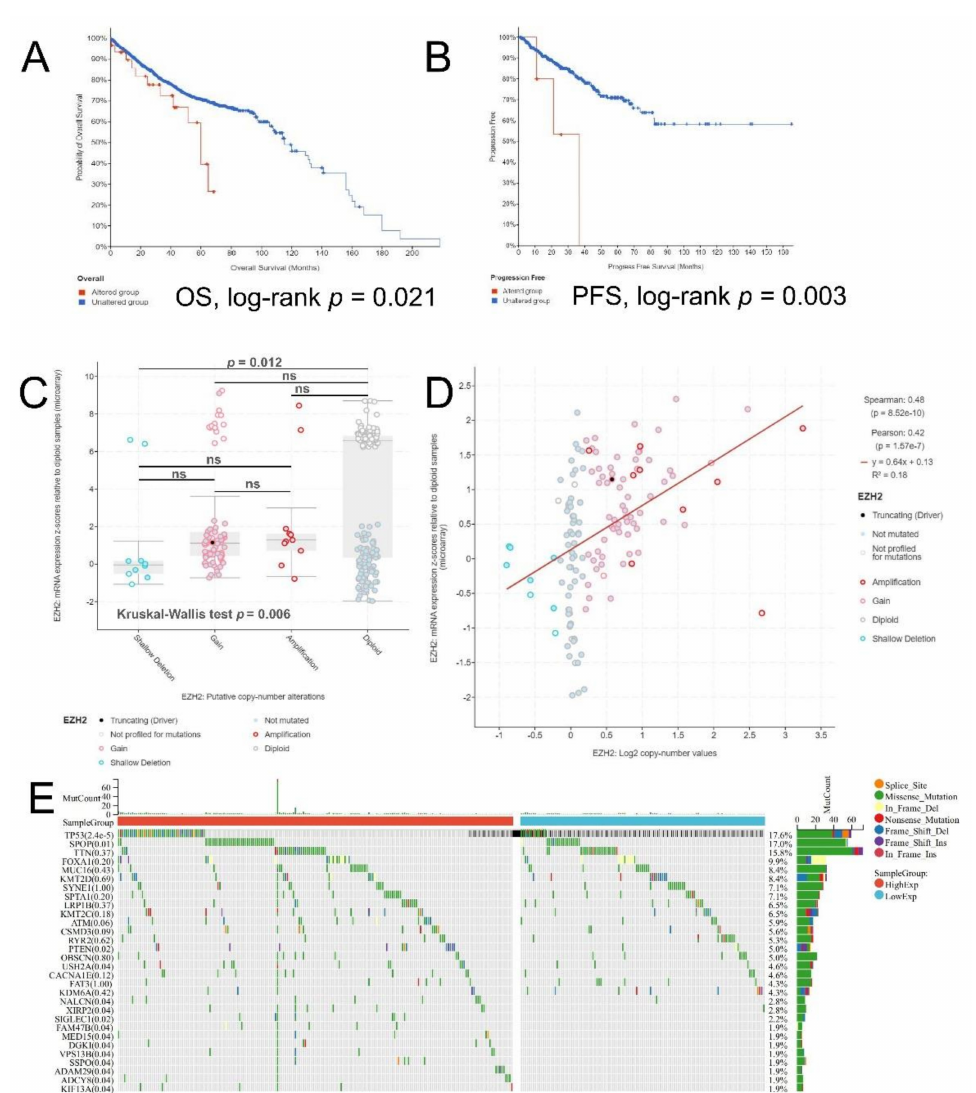
Figure 6. Genetic alteration analysis of EZH2. The survival curves of EZH2 unaltered and altered groups in ( A ) OS and ( B ) PFS. ( C ) Deletion, diploid, copy number gain and amplification are involved in the deregulation of EZH2 expression as analyzed by cBioPortal. ( D ) Association between EZH2 mRNA expression and CNV. ( E ) Waterfall plot shows the mutation landscape by using WGS data from the TCGA-PRAD